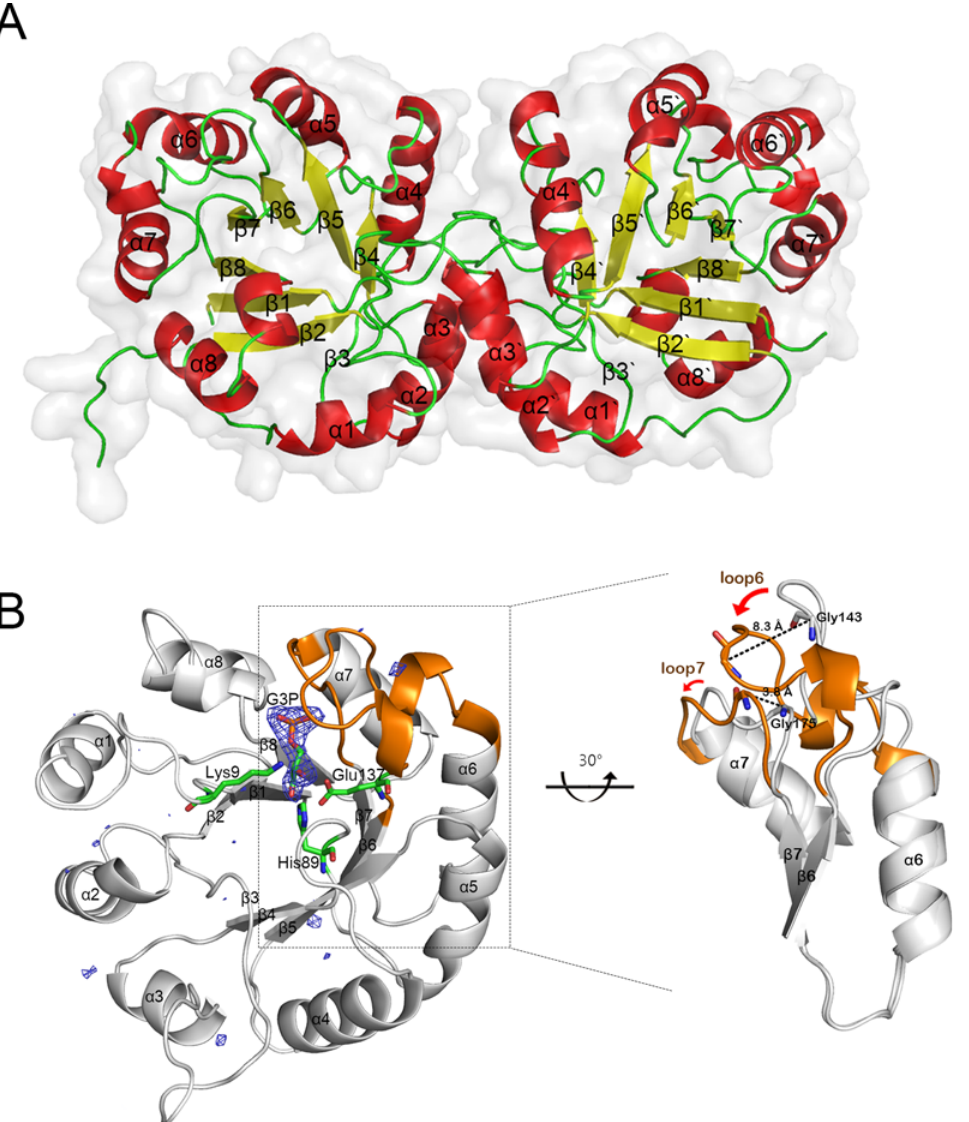
Fig 1. Overall structures of apo- and G3P-bound TaTPI. (A) Homodimer of apo-TaTPI is shown in carton representation, where α -helix, β -strand, and loop are colored in red, yellow, and green, respectively. (B) G3P-bound TaTPI. Only monomer of homodimeric G3P-bound TaTPI is demonstrated to emphasize a conformational change compared with apo-TaTPI. Extra positive electron density in F o -F c omit map contoured at 3.0 δ is shown as a blue mesh, which is modelled as G3P later. Amino acid residues interacting with G3P in catalytic site and G3P are shown as stick model; carbon, oxygen, phosphorus, and nitrogen atoms are colored in green, red, orange, and, blue, respectively. Loop 6 and loop 7 regions, which show a distinctive conformational change upon binding of G3P, are represented in orange and magnified for